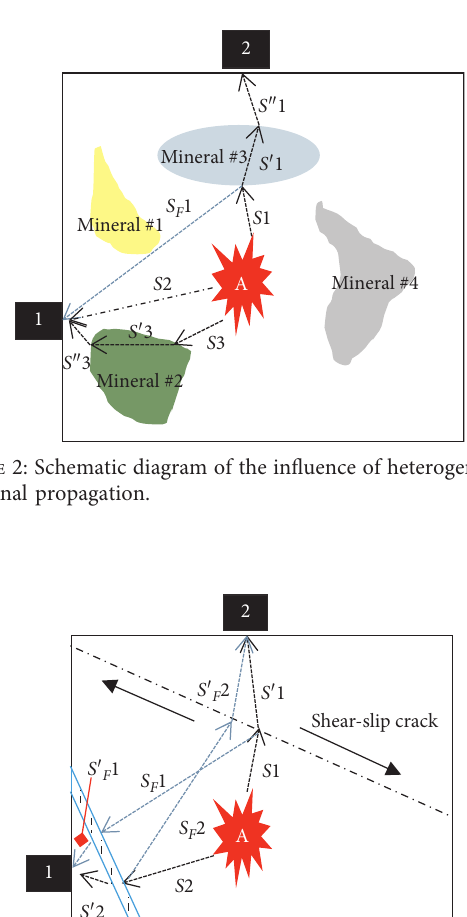
Table 2: rock fracture behaviour and signal distortion